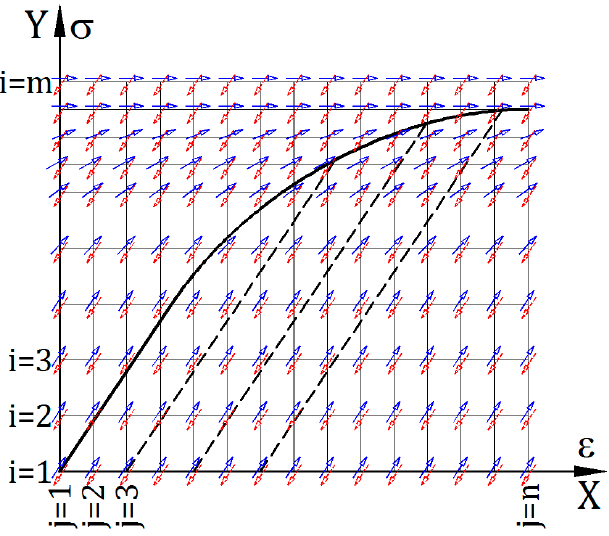
Figure 1. Graphical interpretation of the stiffness matrix structure. In Figure 1, both the X axis ( ε values) and Y axis ( σ values) were digitized, but the division does not have to be uniform. X-axis values are collected in the X vector: